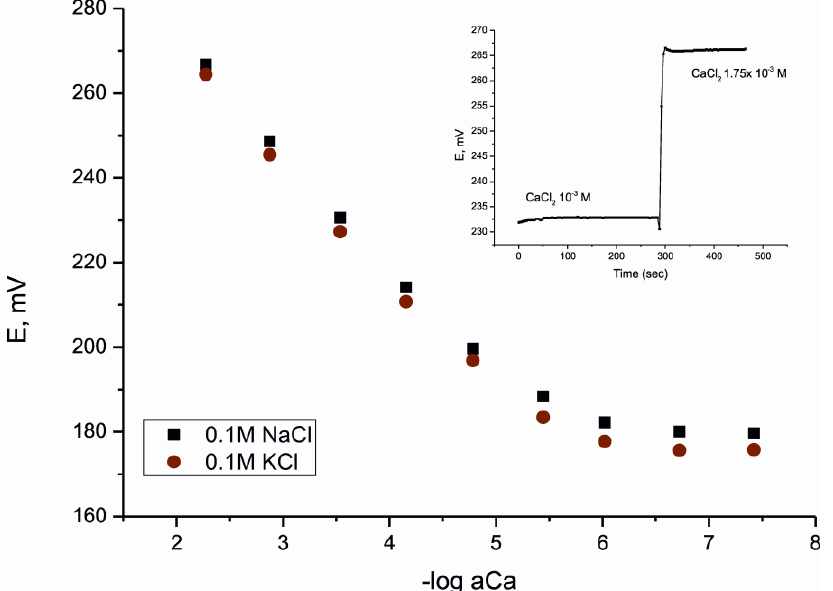
Figure 2. Solid contact electrode design and cross-section of the electrode area. 1 —COP substrate; 2 —thin film gold layer; 3 —poly NPEDMA conductive polymer layer; 4 —polyurethane diacrylate based ion selective membrane; 5 —encapsulating layer based on an acrylic pressure sensitive adhesive (PSA).